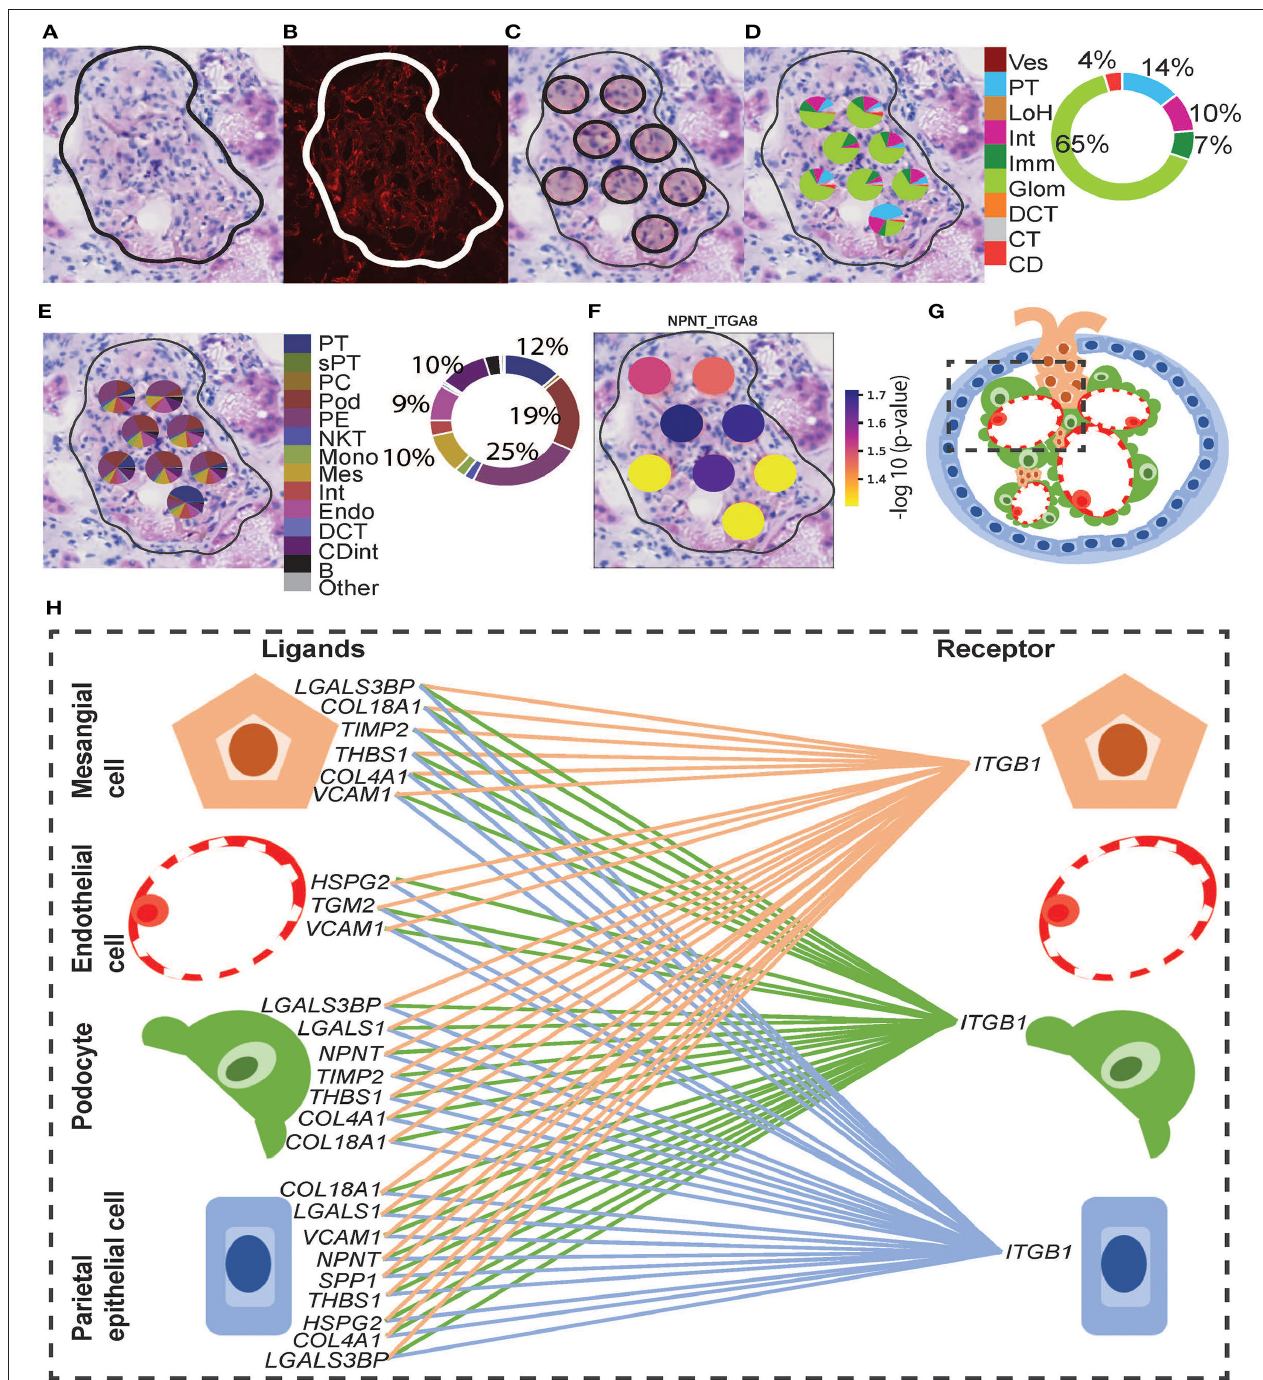
FIGURE 5 | Integrative analysis of glomerular morphology, deconvolution, and cellular interactions in patient D. To confirm the morphology of glomerular functional structures, we investigated H&E and mIF images within a selected glomerulus. (A) Zoomed-in H&E image of the selected glomerulus annotated by the pathologist. (B) Anti-CD31 (red) immunofluorescence staining confirms the presence of endothelial cells and validates the pathologist’s glomerular annotation. Next, we visualized the ST-spots underlying the glomerulus. (C) The positions of the eight underlying ST-spots were mapped within the selected glomerulus. To perform deconvolution, we selected the ST-spots identified by label transfer as glomeruli. (D) Deconvolution at the functional structure level for the selected glomerulus was mapped to the H&E image. The pie chart provides a summary of functional structures underlying all glomerular ST-spots in the entire tissue section for patient D. ( E) Deconvolution at a cell-type level for the selected glomerulus was mapped to the H&E image. The pie chart provides a summary of the cell types underlying all glomerular ST-spots in the entire tissue section for patient D. Finally, we investigated our ST-seq datasets for cellular interactions in glomerular ST-spots. (F) The spatial expression of